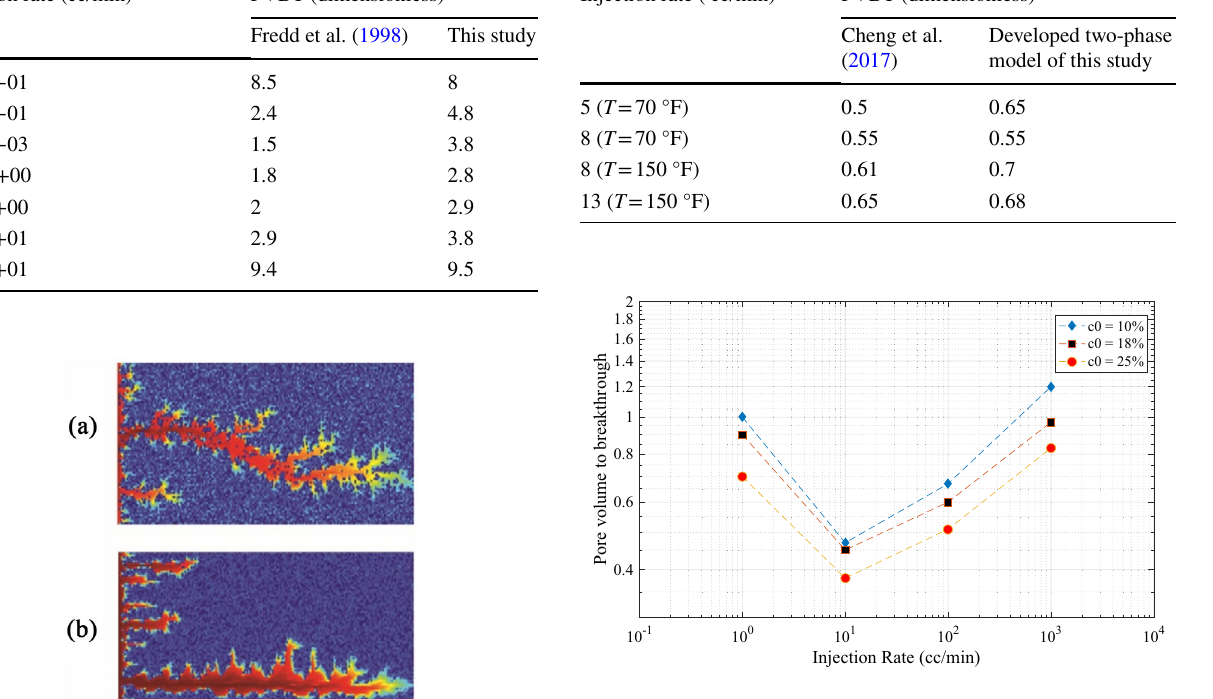
Table 4 Comparison of the results of this study and experiments by Cheng et al. (2017) Injection rate ( cc/min) PVBT (dimensionless)